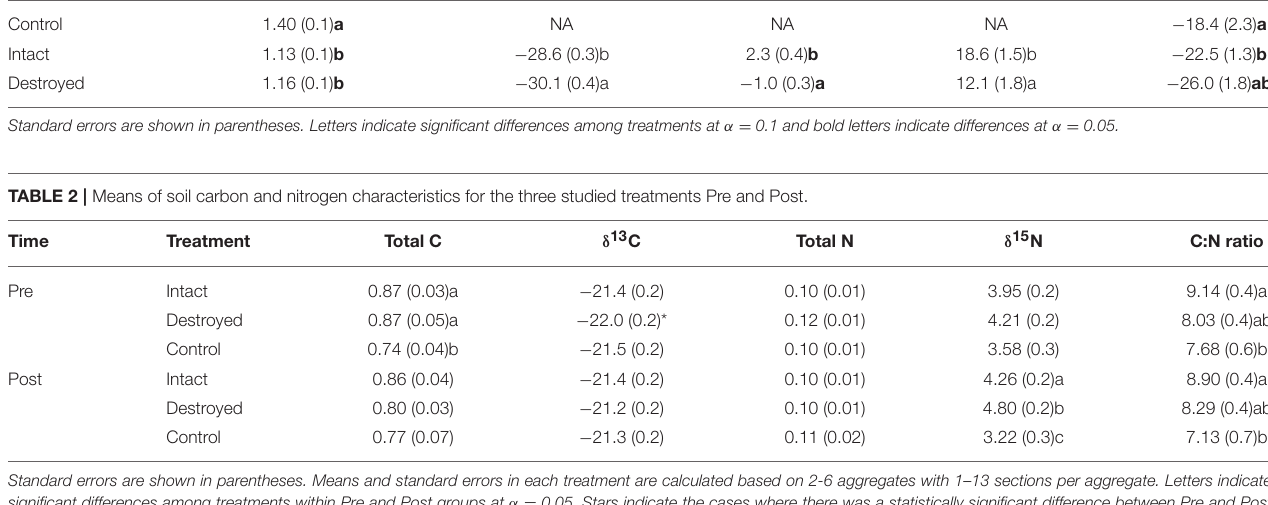
TABLE 1 | Means of soil bulk density ( n = 2) and characteristics of rye roots ( n = 4) from the studied treatments. Treatment